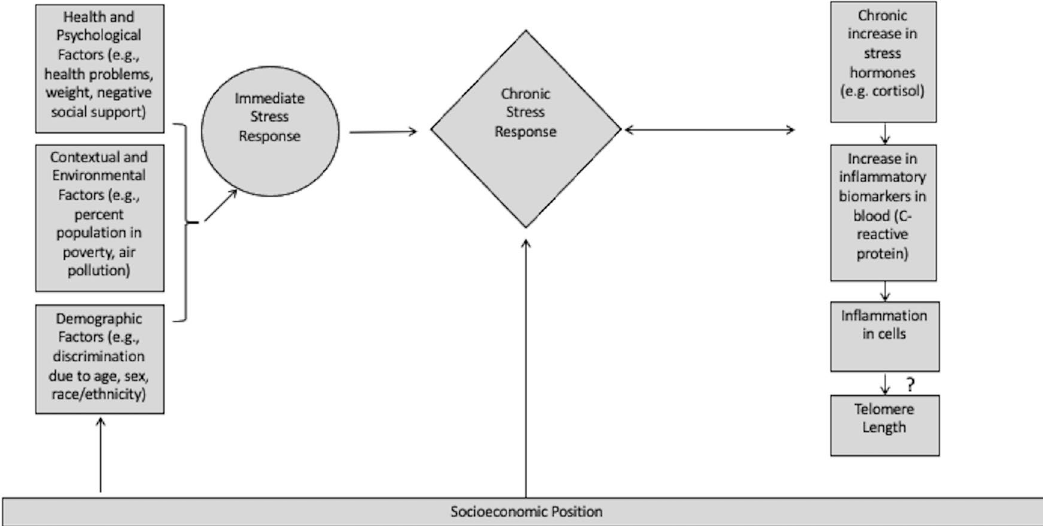
Figure 1. Conceptual model of social determinants on TL. Derived from Barr 11 , Kubzansky 13 , Riancho and Brennan-Olsen 14 , and Gough and Godde 12